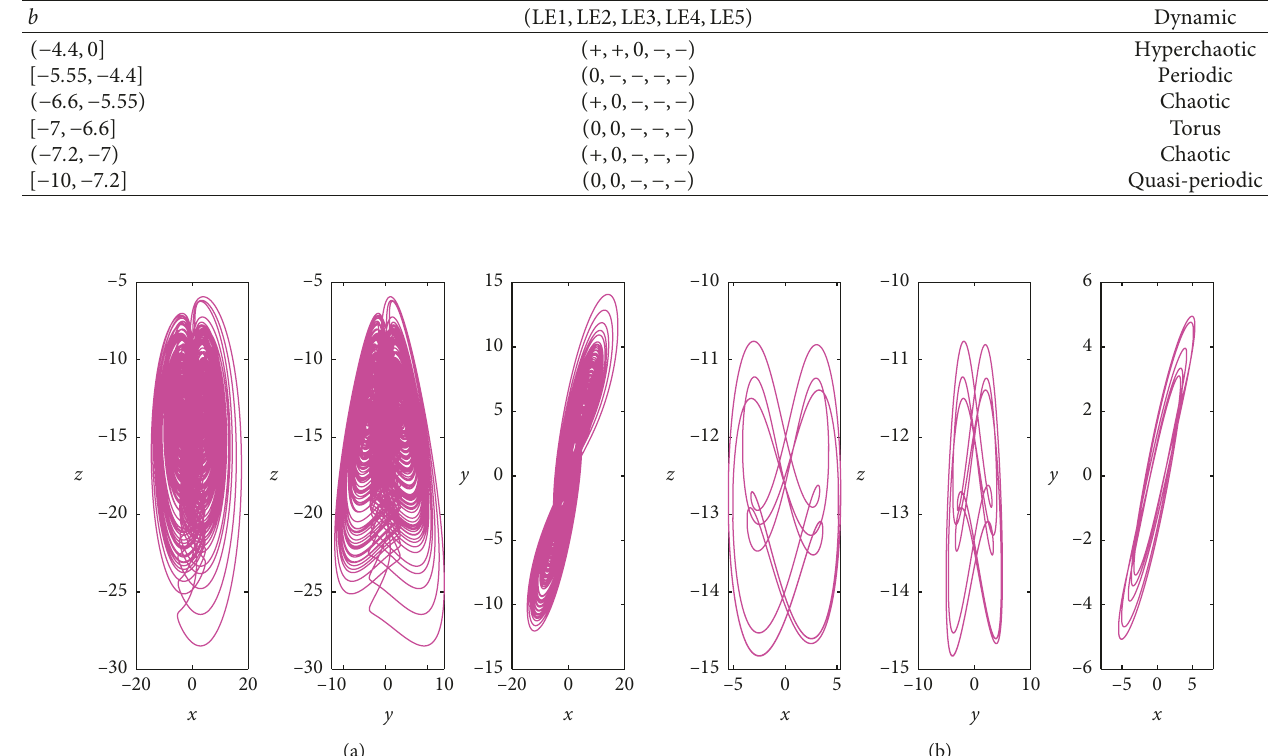
Table 1: The LEs and dynamical behavior under different parameter range of b .